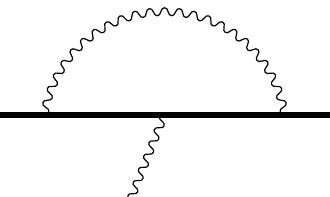
Figure 1. Second-order vertex diagram. There is only one diagram. The straight and wavy lines represent electron and photon propagators, respectively. Reprinted from